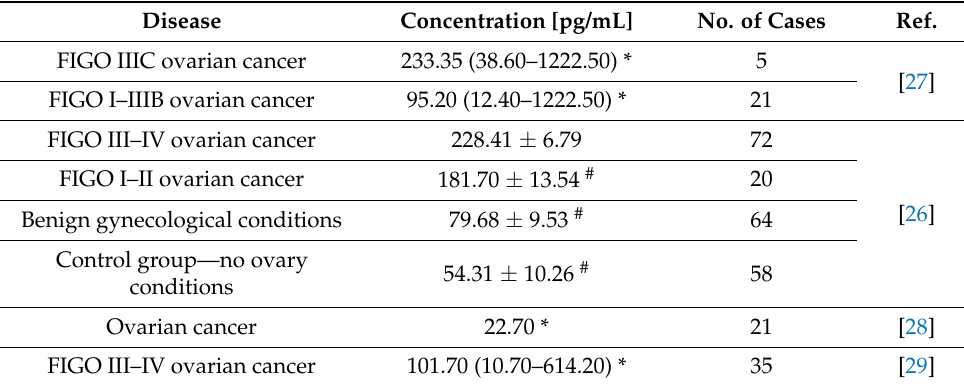
Table 6. Concentrations of interleukin 8 (IL-8) in blood